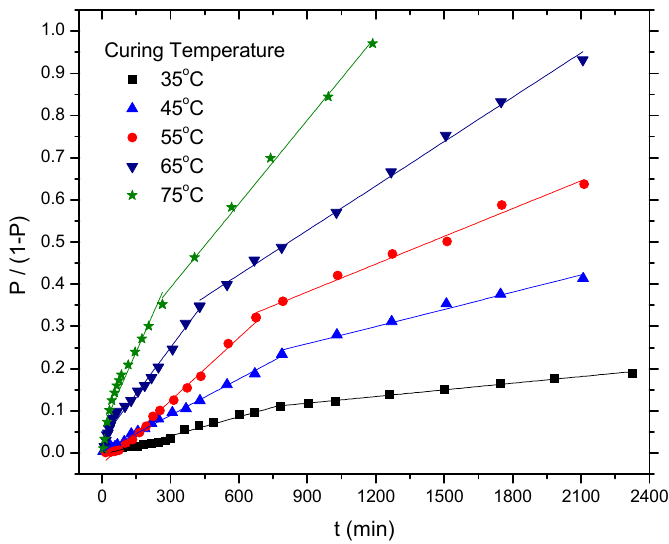
Figure 3. The plot of P/(1 − P) versus time at various curing temperatures for the HTPB-IPDI binder system.